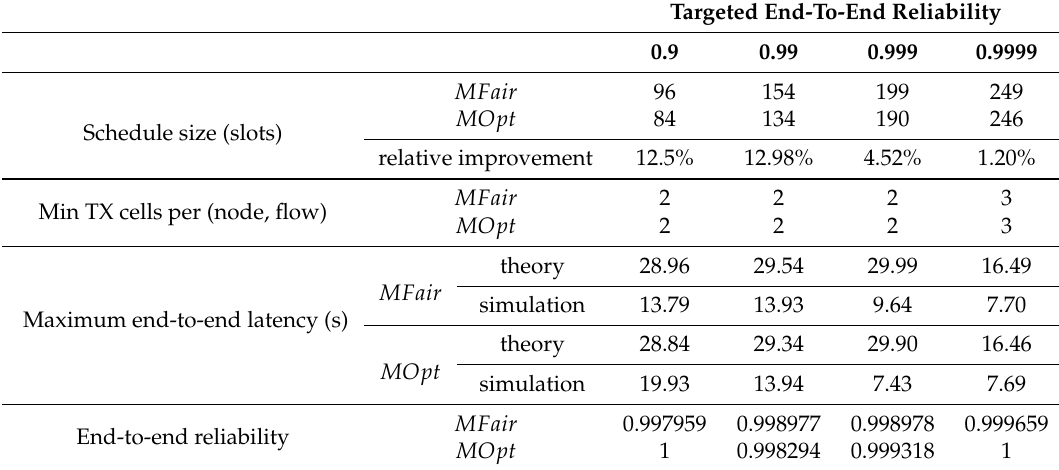
Table 10. Comparison of the theoretical maximum end-to-end latency and the simulation results for MFair and MOpt , taken from particular simulations having the same routing